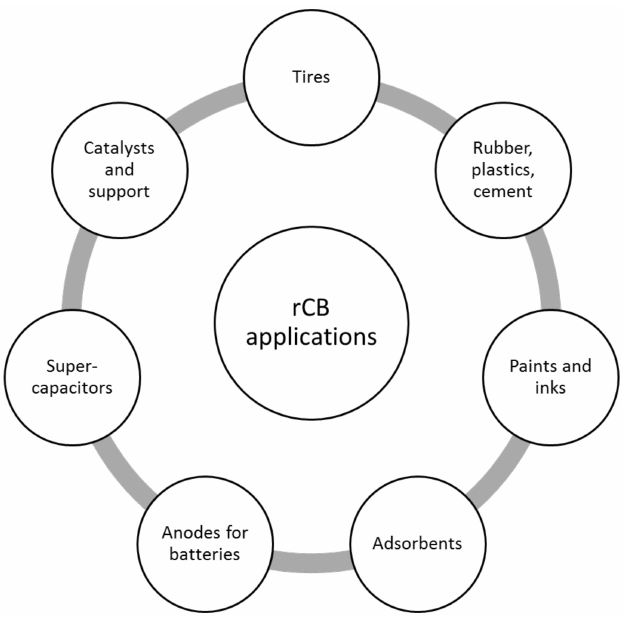
Figure 4. Prospective application fields of